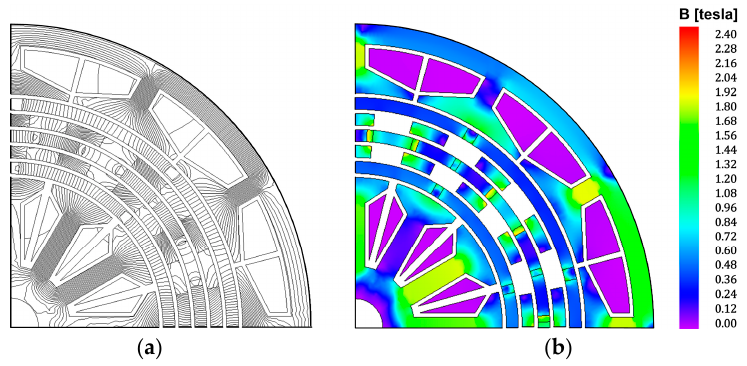
Figure 3. Magnetic flux plot of the generator quarter section by 2D FEM on load: ( a ) Magnetic flux lines distribution; ( b ) Magnetic flux density distribution.